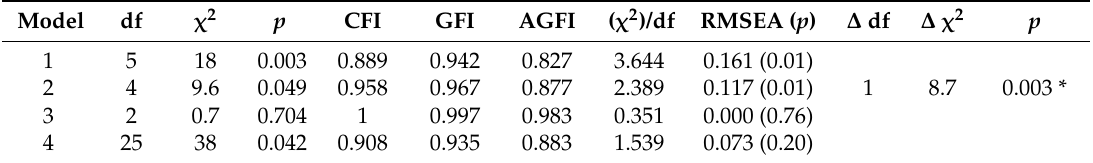
Table 6. Fit Indices and Model Comparison.